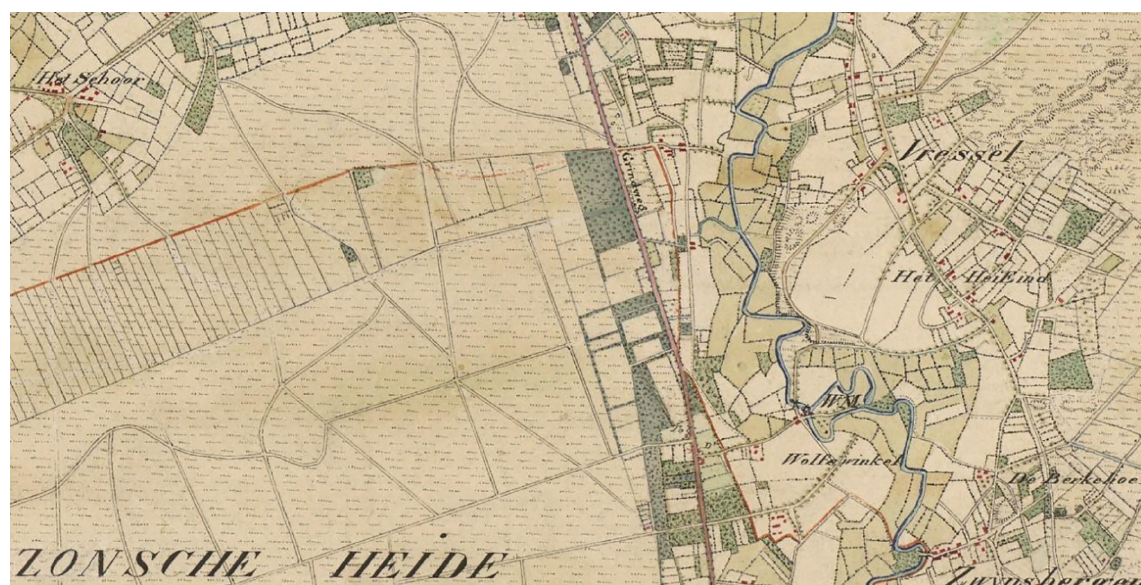
Figure 2. Part of the Dommel Basin in 1837, showing meadows along the river (light green), arable land (white), and large tracts of heath (“heide”). The Zonsche Heide is now mostly arable land, with forests and new residential areas in the south. “WM” indicates a water mill. (National Archives, topographical map of the area around Boxtel and Sint Oedenrode (detail), toegang 4.TOPO, inv. nr